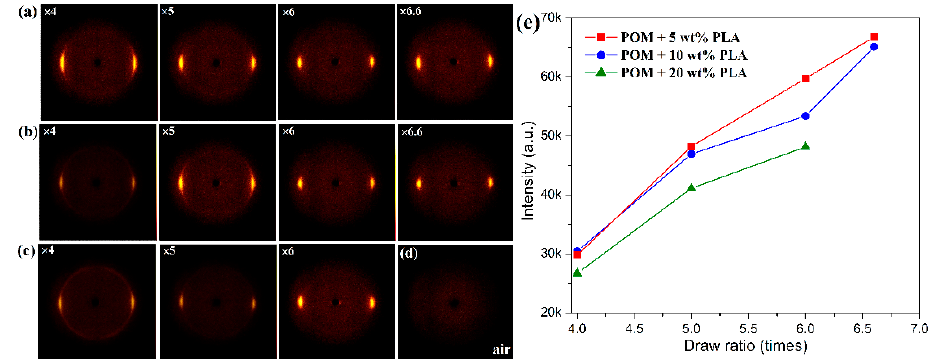
Figure8. Two-dimensionalwide-angleX-rayscattering(2DWAXS)patternsofPOM / PLLAbicomponent Figure 8. Two-dimensional wide-angle X-ray scattering (2D WAXS) patterns of POM/PLLA fibers containing ( a ) 5, ( b ) 10, and ( c ) 20 wt % PLLA at di ff erent draw ratios, and ( d ) air as a reference; bicomponent fibers containing ( a ) 5, ( b ) 10, and ( c ) 20 wt % PLLA at different draw ratios, and ( d ) air ( e ) plots of the azimuthal di ff raction intensity at 2 θ = 23.05 ◦ on the equator plane for the (100) reflection as a reference; ( e ) plots of the azimuthal diffraction intensity at 2 θ = 23.05° on the equator plane for of the bicomponent the (100) reflection of the bicomponent fibers.